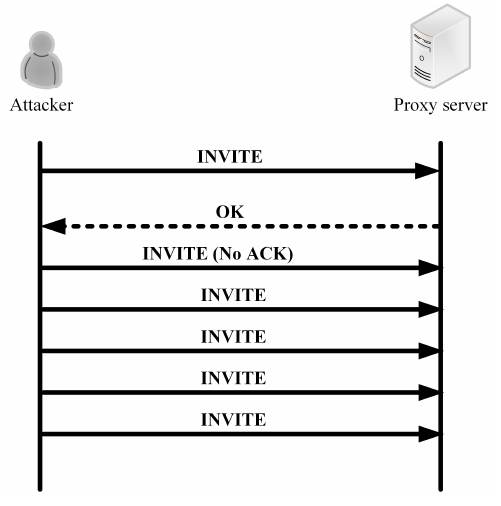
Figure 4. An INVITE flooding